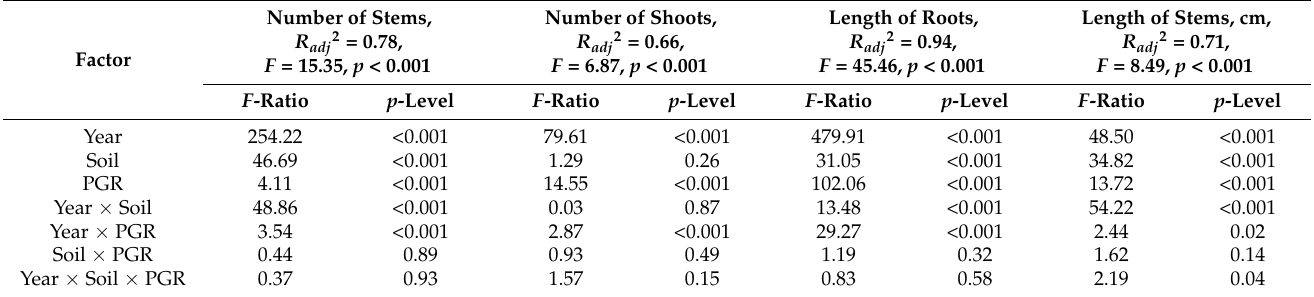
Table 5. Evaluation of the effect of the research factors, PGRs, soil type, and year of vegetation, on